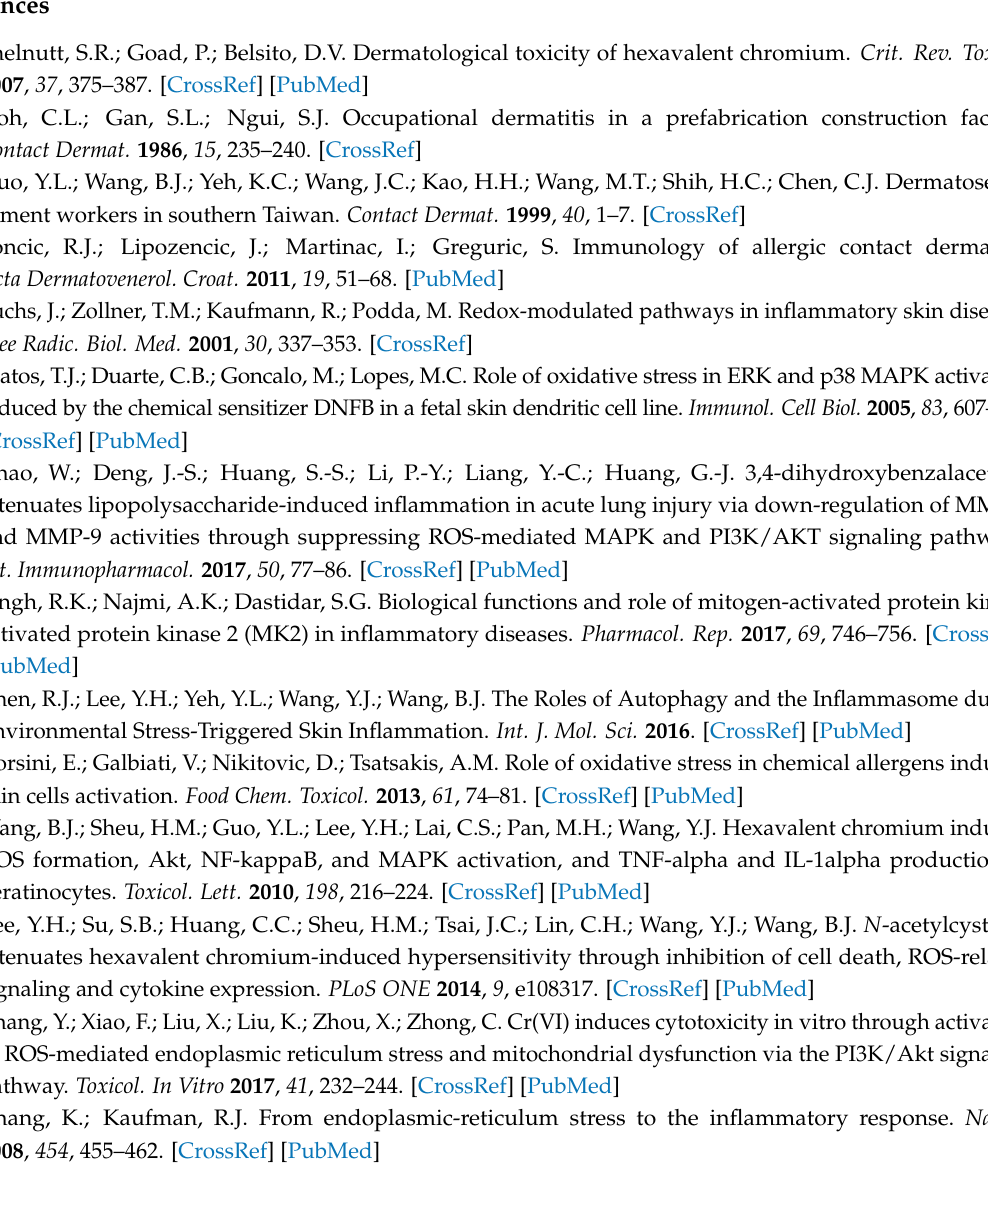
Figure S1: Chemical structure of trans -3,5-dimethoxy-4 (cid:48) -hydroxystilbene (pterostilbene), Figure S2: Percentage of apoptotic cells determined in different Cr(VI) concentrations. The EC50 value for apoptosis was 84.303 µ M. Data presented as the mean ± standard deviation (SD) from three independent experiments, Figure S3: DPPH radical scavenging activity of PT. PT antioxidant activity was assessed via the percent inhibition (radical scavenging) of DPPH. Vitamin C (200 µ M) was used as a positive control. All tests were performed in triplicate and results are expressed as means ±